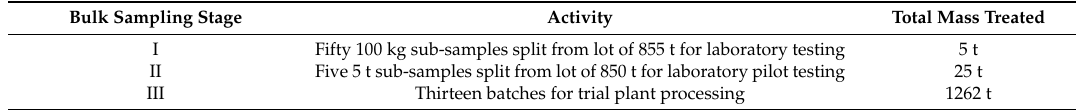
Table 8. Summary of bulk sampling programme stages and tonnes treated from the